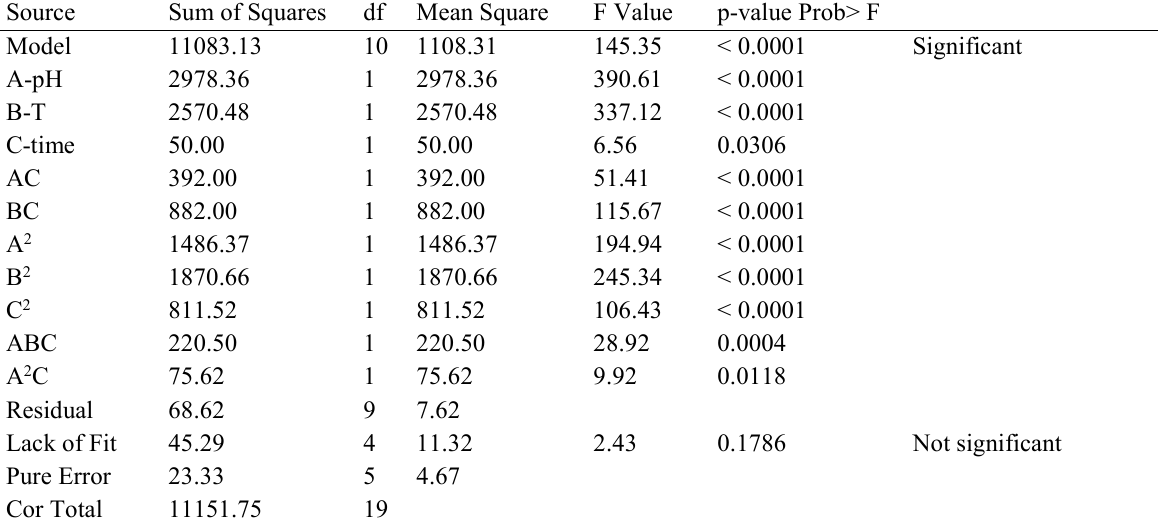
Table 4. Analysis of variance for the response surface reduced cubic mode